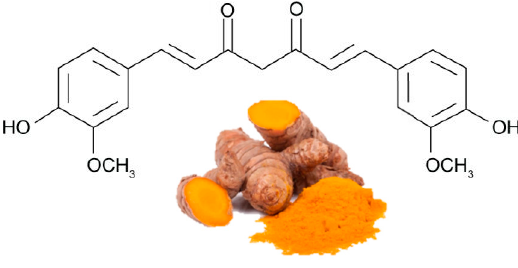
Figure 4. The major sources of curcumin and its chemical structure (keto form).